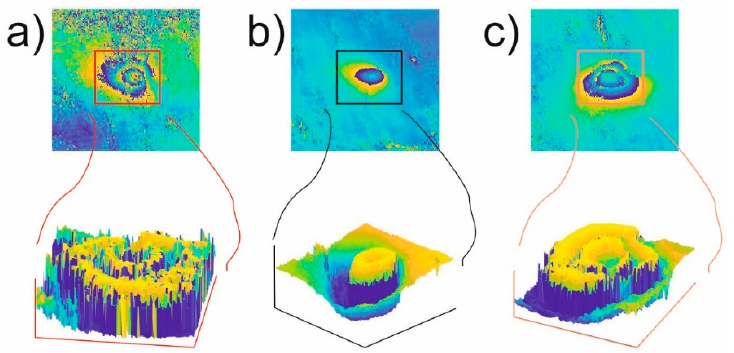
Figure 1. Examples of subsidence troughs visible on interferograms computed for radar images recorded on 4 April 2017 and 16 April 2017 ( a , b ) and 24 December 2017 and 5 January 2018 ( c ) for the area of the Upper Silesian Coal Basin, Poland (Sentinel-1A, descending).